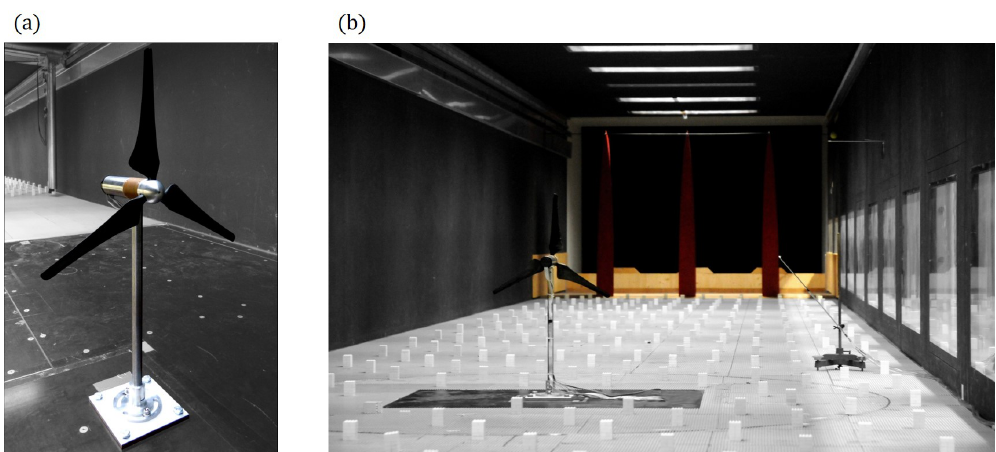
Figure 5. ( a ) Model Wind Turbine and ( b ) Model Wind Turbine within the boundary layer wind tunnel with roughness elements and barriers for the SBL